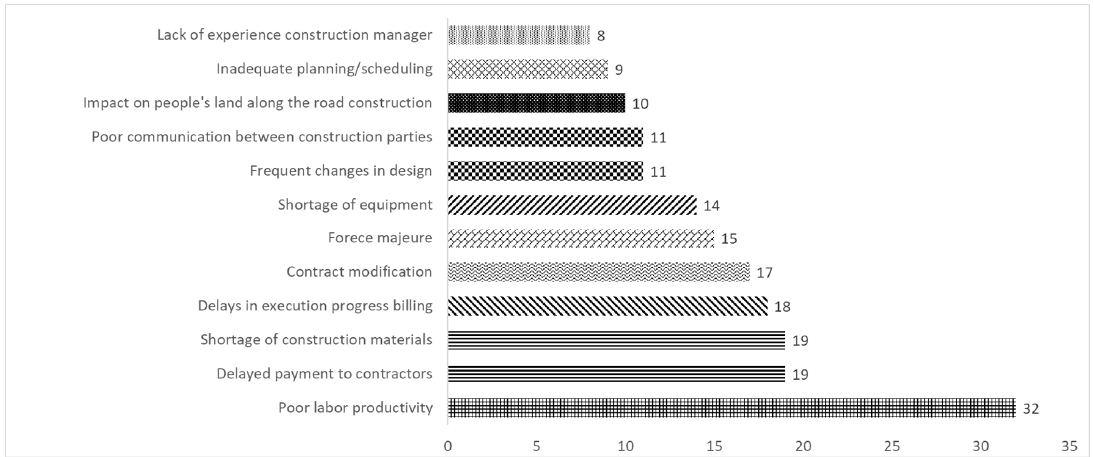
Figure 2. Intensity for the delay causes.